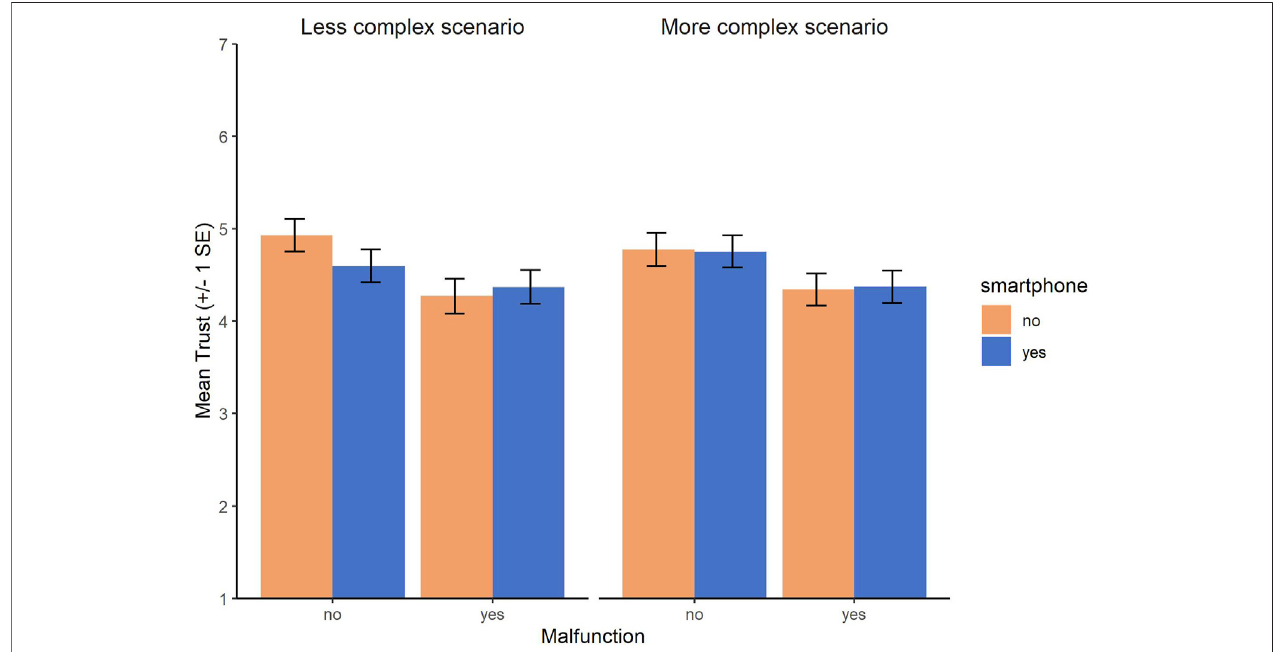
FIGURE 7 | Trust by system malfunction , crossing pedestrian ’ s smartphone use , and scenario complexity . Error bars represent standard errors. Higher ratings represent higher trust. For results of signi fi cance tests, see text.